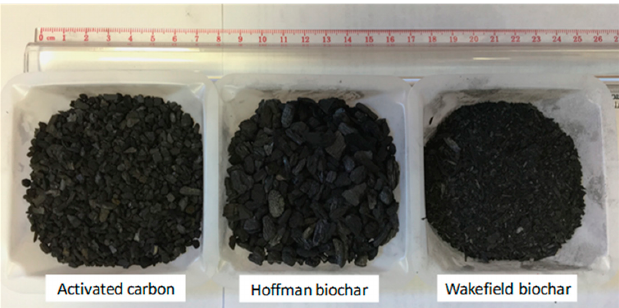
Figure 2. Pyrogenic carbon materials tested in this study. Table 1. pH and elemental composition (weight %) of pyrogenic carbon